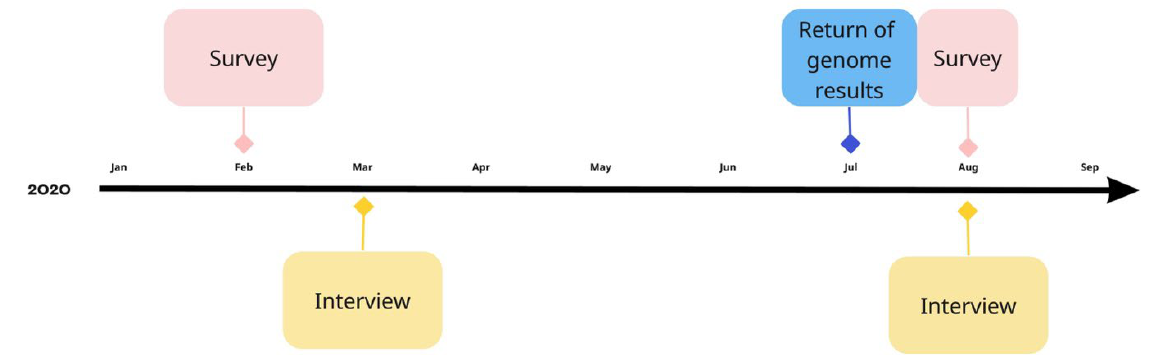
Figure 3. Timeline of survey questionnaires and interviews in the IAM Frontier study (made in Miro).